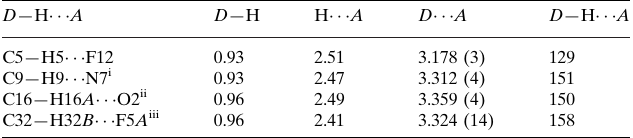
Hydrogen-bond geometry (A˚ , (cid:2)